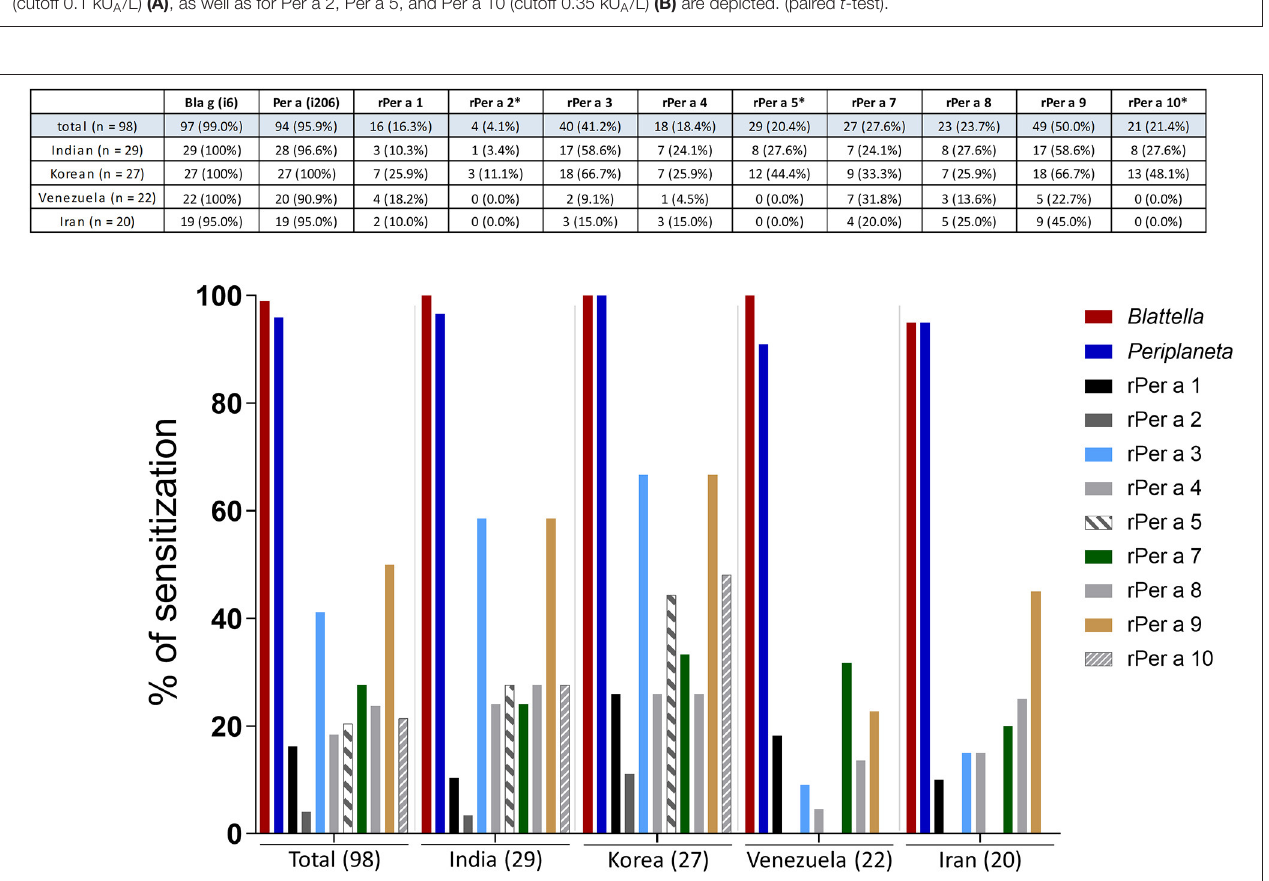
FIGURE 4 | Comparison of IgE antibody levels to Periplaneta (i206), Blattella (i6), and purified recombinant Periplaneta allergens in respective patient collectives from India ( n = 29), Korea ( n = 27), Venezuela ( n = 22), and Iran ( n = 20). Prevalence (%) of IgE sensitization to Per a 1, Per a 3, Per a 4, Per a 7, Per a 8, and Per a 9 (cutoff of 0.1 kU A /L) and Per a 2*, Per a 5*, and Per a 10* (cutoff of 0.35 kU A /L) are shown.